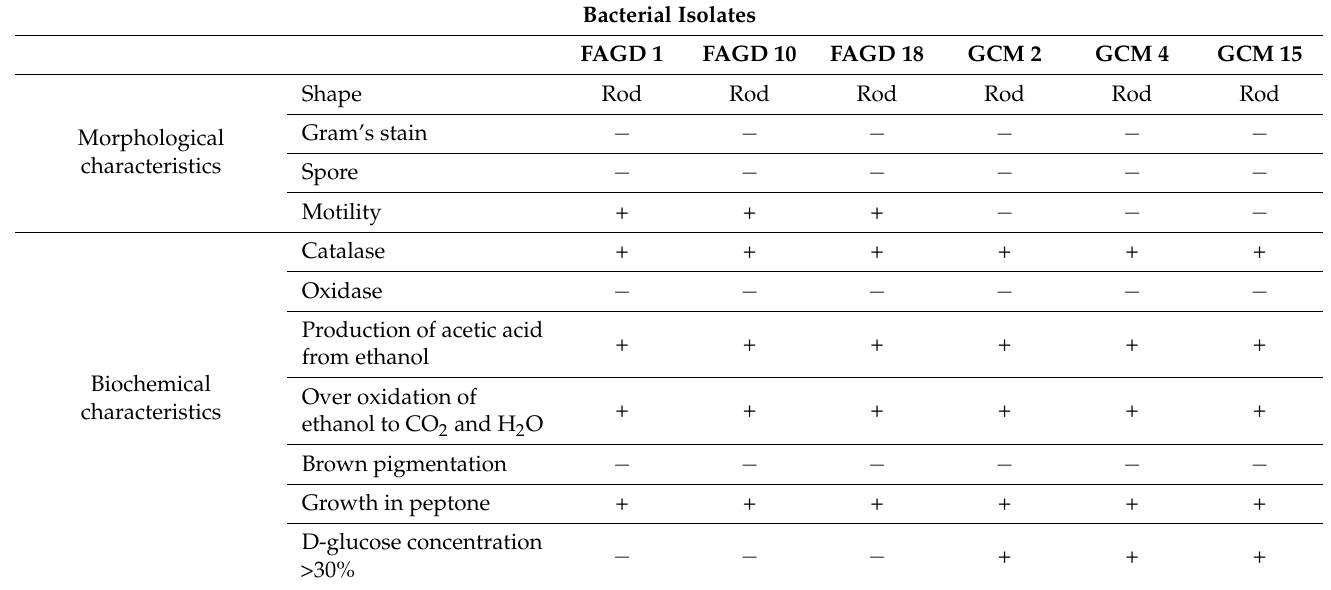
Table 1. Morphological and biochemical characteristics of the six selected strains.